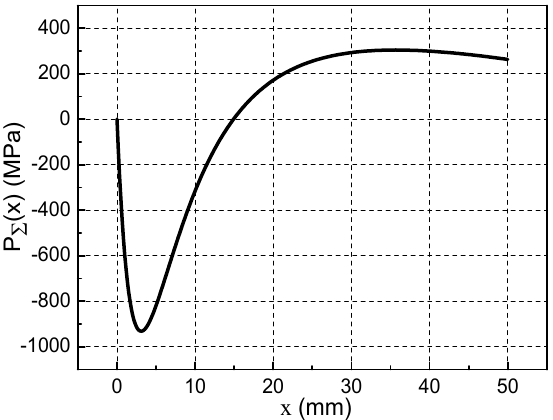
Figure 13. Total pressure of metal liquid film at U=2000 m/s.